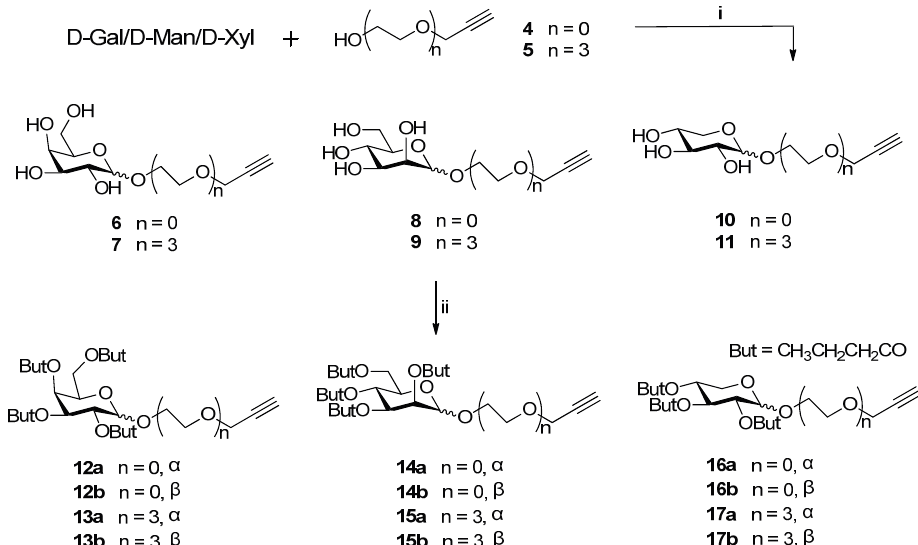
Reagents and reaction conditions : ( i ): cat. H 2 SO 4 -silica, 65 °C, 69%–75%. ( ii ): n -butyric anhydride, pyridine, 16 h, 0 °C, 89%–96%.